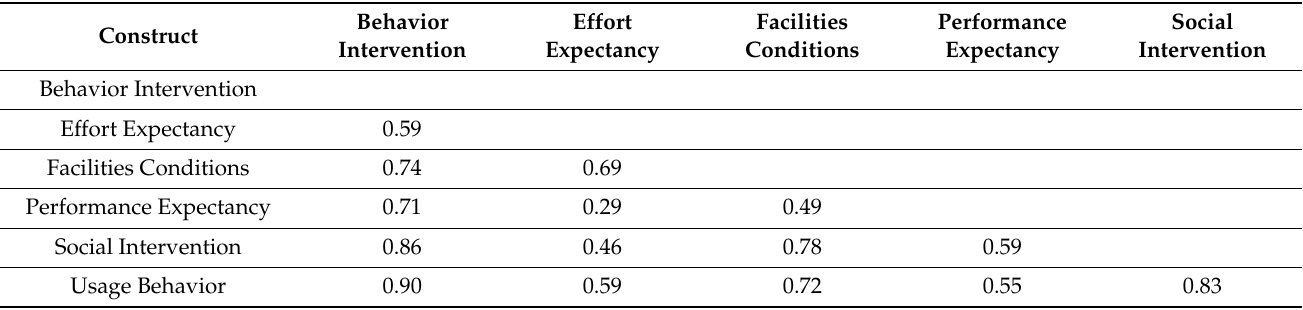
Table 6. Additional validity discriminant measurement results based on HTMT.